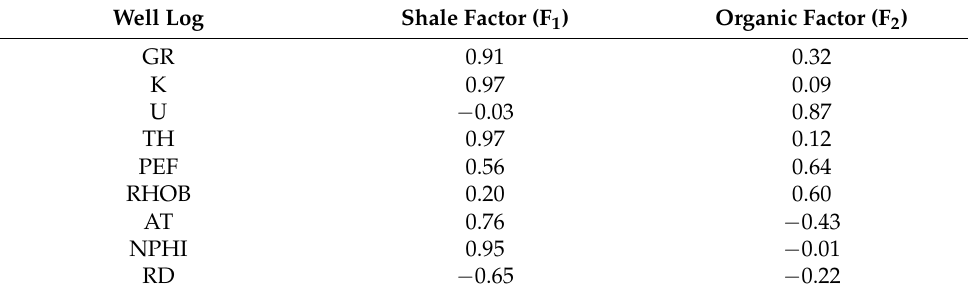
Table 2. Factor loadings rotated using the varimax algorithm for Well